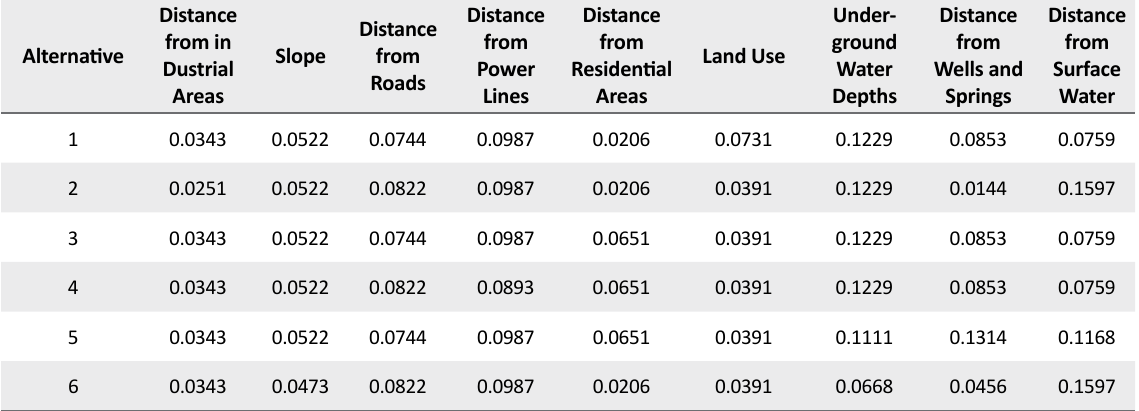
Table 11. Difference matrix between the normalized matrix points of fuzzy TOPSIS decision making and the negative ideal